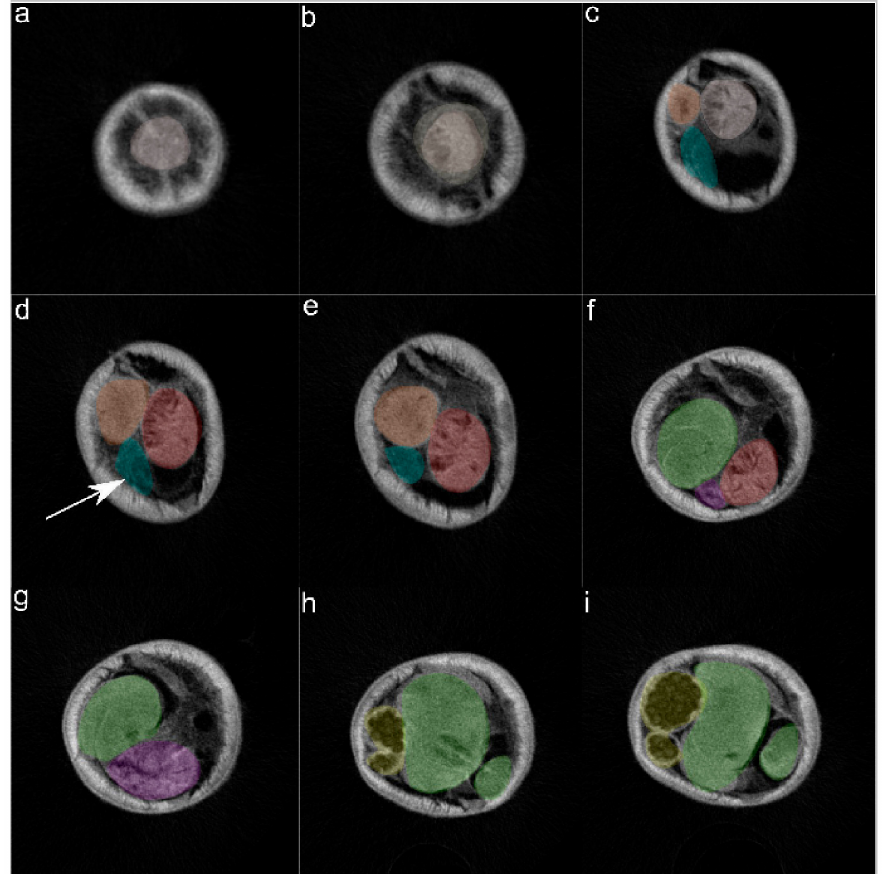
Figure 4. Representative transversal 2D renderings of the adult Pseudoterranova azarasi forebody overlaid by colors respective to di ff erent nematode organs: ( a ) esophagus (light pink); ( b ) nerve ring (light beige) surrounding the esophagus; ( c ) excretory cell (EC; blue) under-positioned by intestinal caecum (orange); ( d ) ventriculus (red) and presumptive excretory duct of the EC (arrow); ( e ) diminishing EC (blue); ( f ) ventriculus entering intestine (green) through funnel-like connection (violet); ( g ) more enhanced connective funnel (violet) flowing into the intestine (green); ( h ) and ( i ) two intestinal loops (green) and gravid uterus